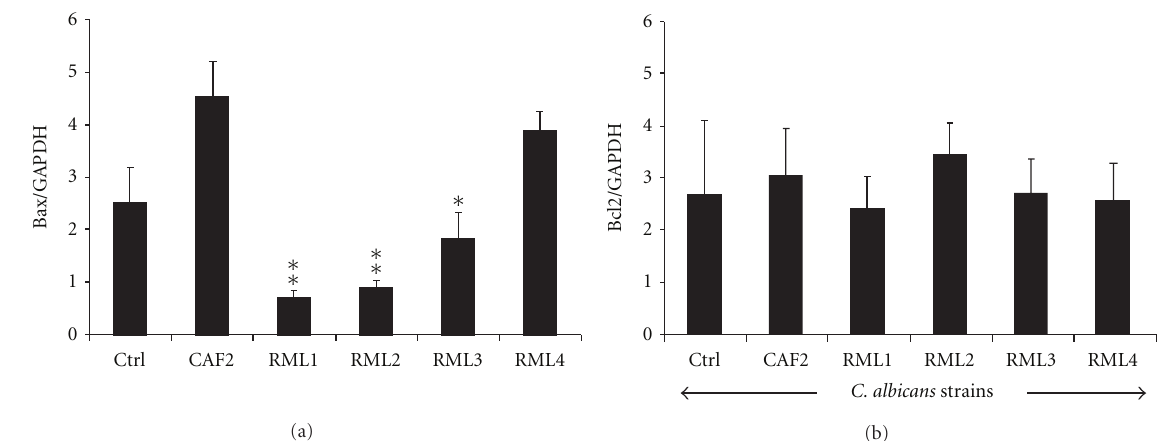
Figure 5: Bax and Bcl2 expression following EHOM infection with C. albicans strains. Total RNAs were extracted from the infected EHOMs and analyzed by RT-PCR for Bax and Bcl2 gene expression. Data are means + SD, n = 5. ∗ P < 0 . 05; ∗∗ P < 0 . 01 significance between the gene expression levels in the CAF2-infected and Caecm33 mutant-infected EHOMs.